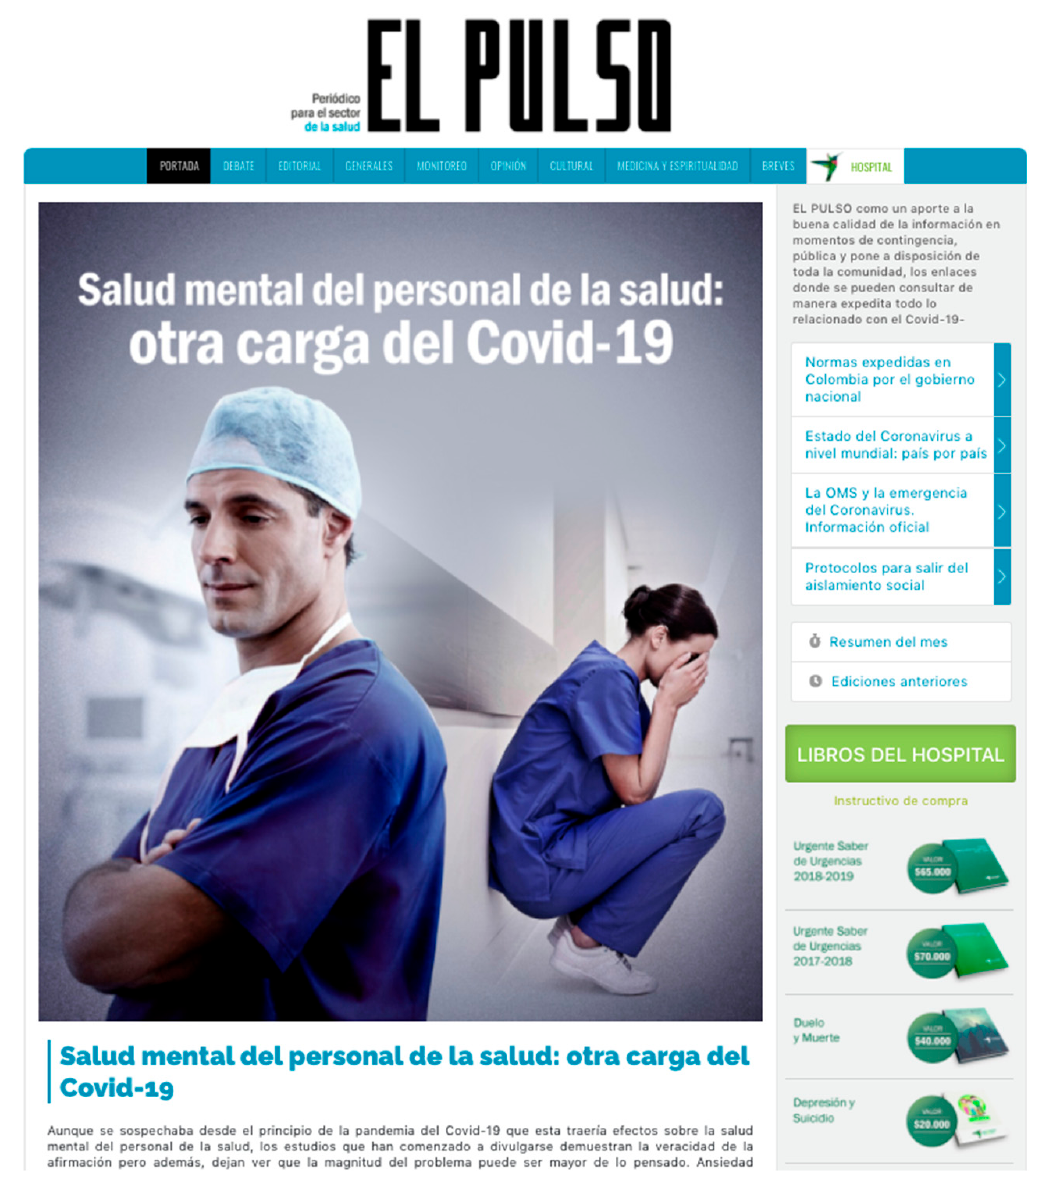
Figure 7. “El Pulso”, online magazine of the Hospital San Vicente Fundación de Medellín (Colombia). Source: Website of the hospital.